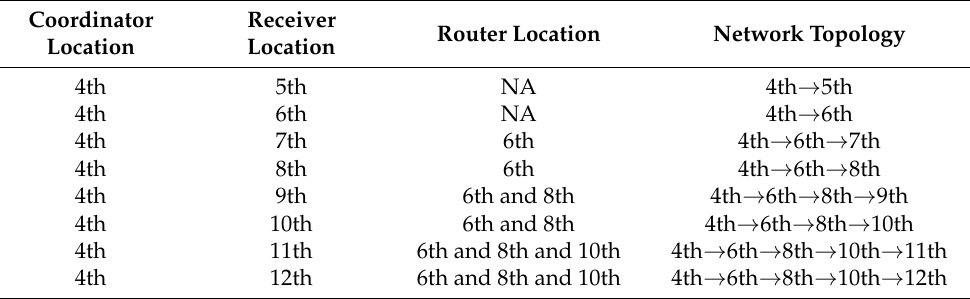
Table 4. Description of ZigBee cascade.